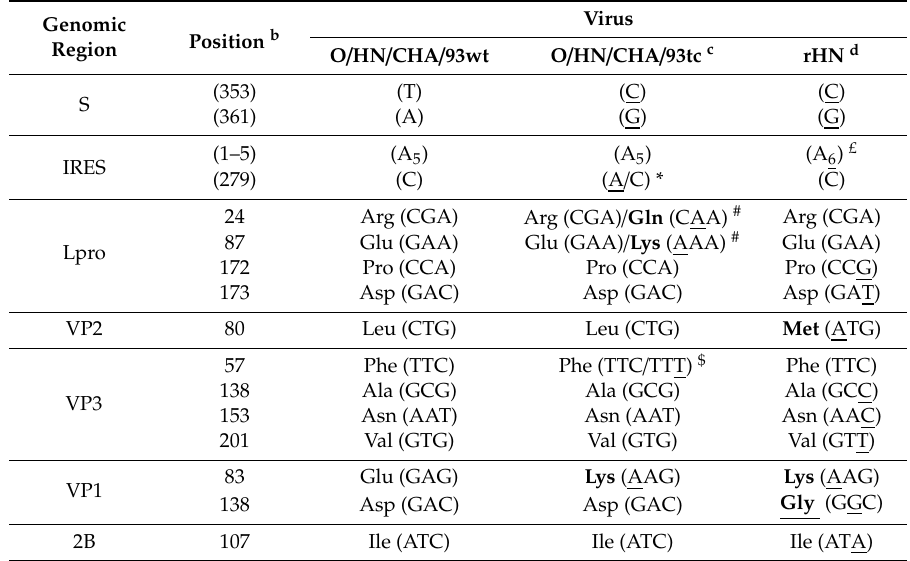
Table1. ComparativeanalysisofthecompletegenomicsequencesofO / HN / CHA / 93wt, O / HN / CHA / 93tc and its genetically engineered virus (rHN) a